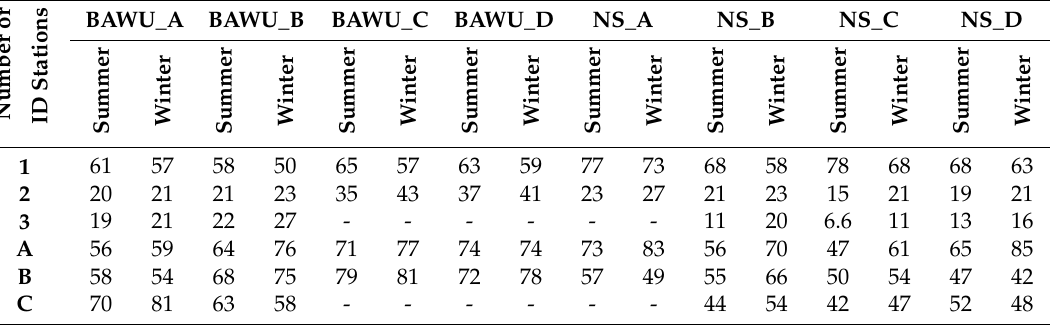
Table 3. Percentages of observed events occurring in several stations simultaneously (1, 2, 3) and in each of the stations (A, B, C) for different seasons and case studies.